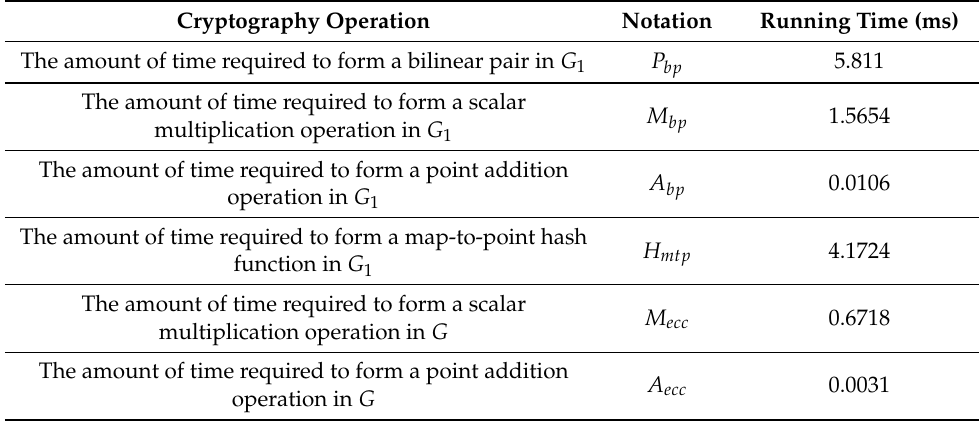
Table 3. A Comparison of the Times Needed for Common Cryptographic